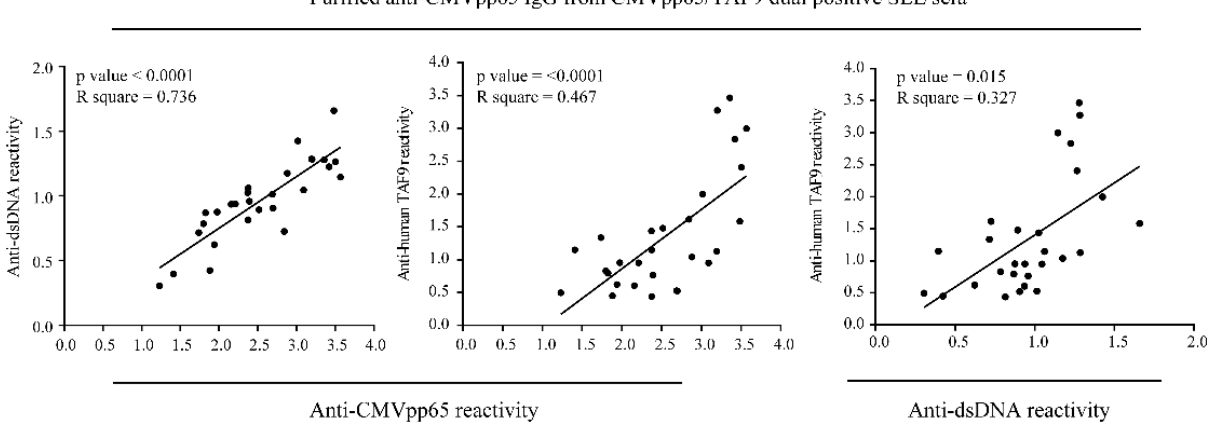
Figure 3. Analysis of the correlation between anti-CMVpp65 IgG, anti-human TAF9 IgG, and anti-dsDNA IgG by ELISA testing with anti-CMVpp65 IgG purified from CMVpp65/TAF9 dual-positive SLE sera ( n = 28).